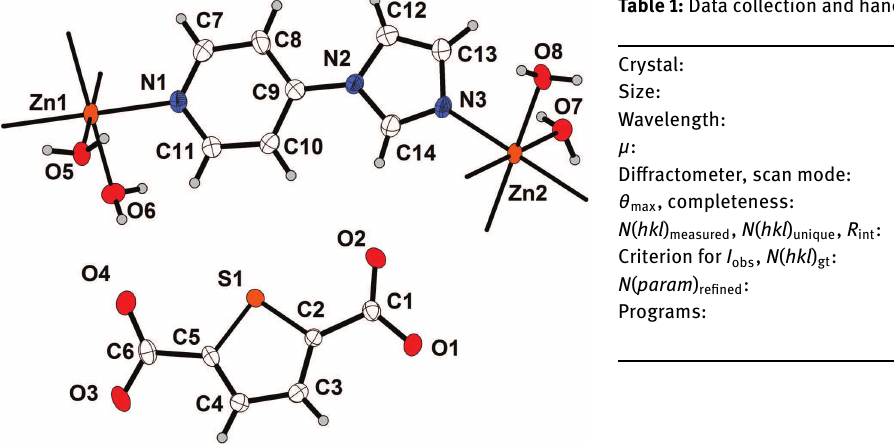
Table 1: Data collection and